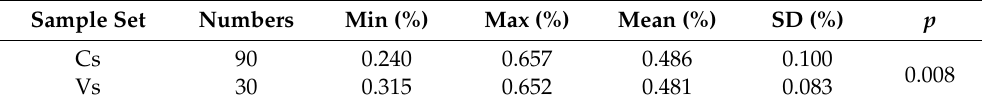
Table 1. Statistics of SCC in Cs and Vs.